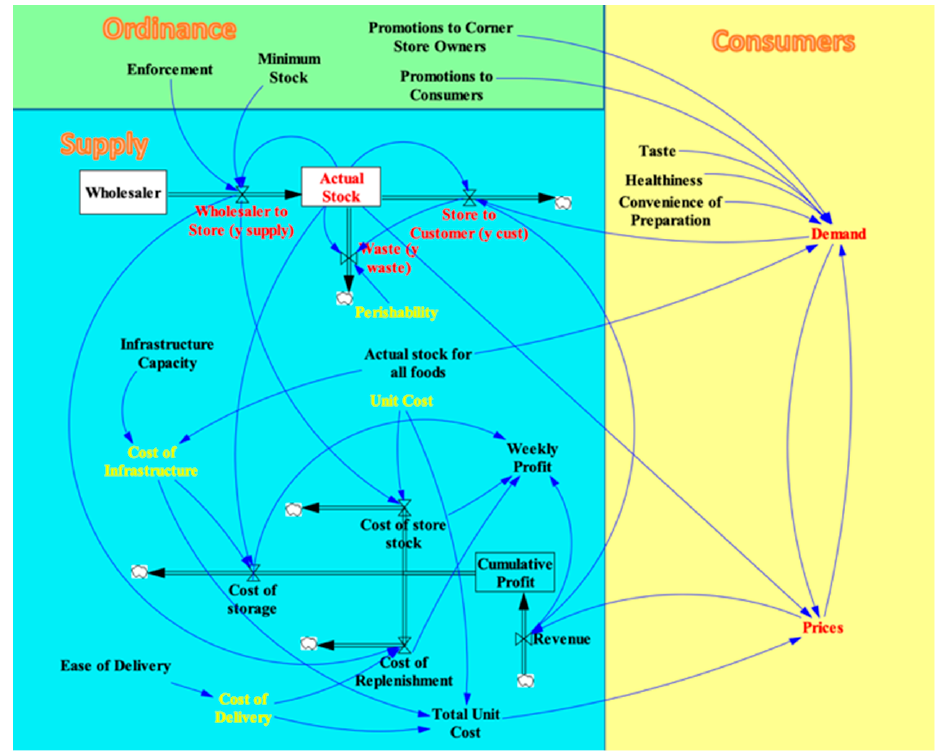
Figure 4. Variables and dependencies within the Ordinance Dimension added to complete the SFO Visual Model.